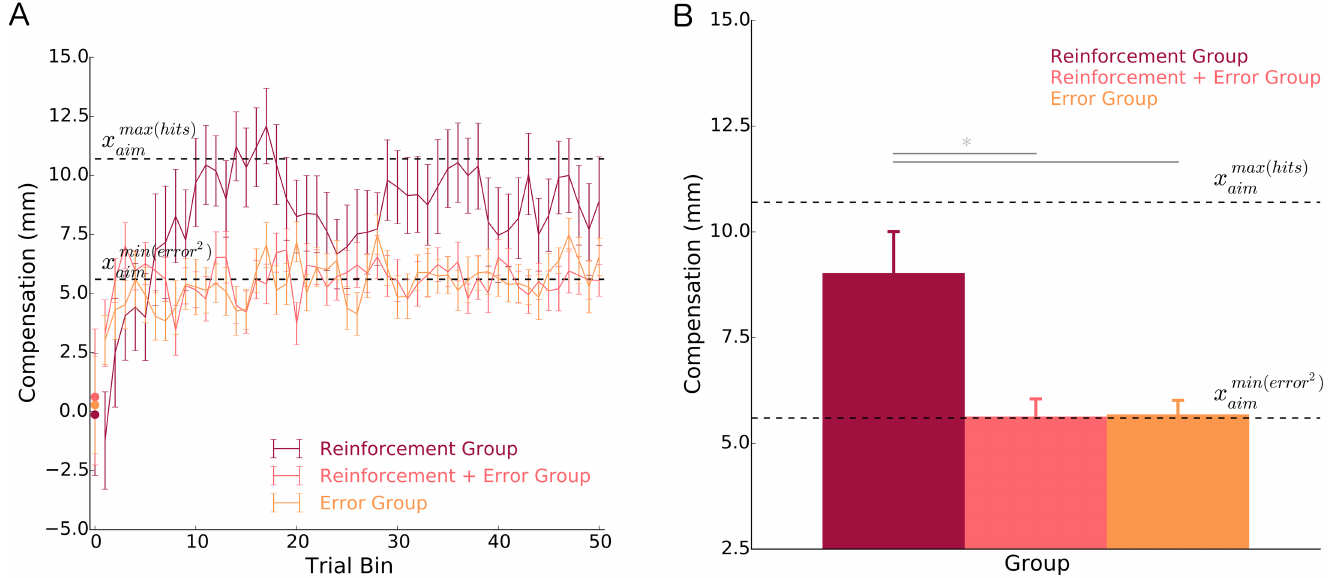
Fig 6. Average pattern of compensation of each group to the skewed lateral shift probability distribution for A) separatebins of trials and B) averagedacross the last 400 trials. In A) , all experimental trials are representedin the line graph (bins 1–50), where each point represents the average of 10 trials. The circles at bin 0 represent the averageof trials 1–3 and are displayedto show the similarity between groupsimmediately after perturbation onset. In both A) and B) , the upper dashed line representsthe optimalcompensation(locationto aim the hand) that maximizesthe probabilityof hitting the target x max ð hits Þ , based on the movement variabilityof the Reinforcement group. The lower dashedline representsthe optimal compensation (locationto aim aim the hand) that minimizes squarederror x min ð error 2 Þ